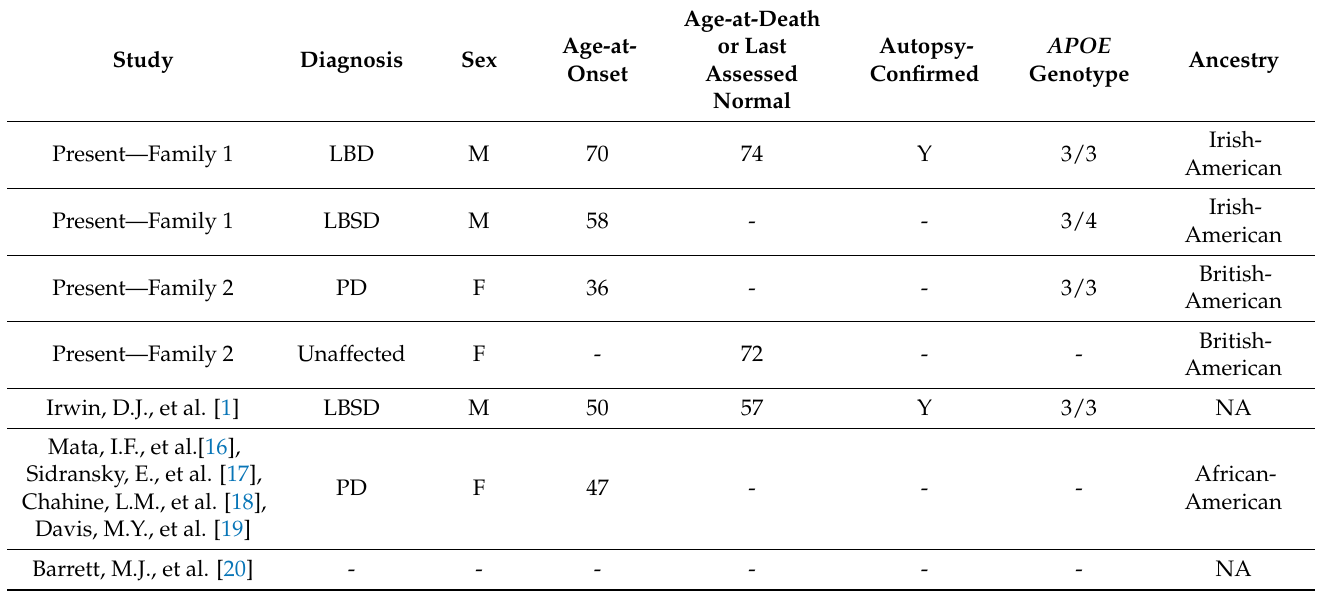
Table 1. Clinical and demographic characteristics of GBA p.R202X heterozygote